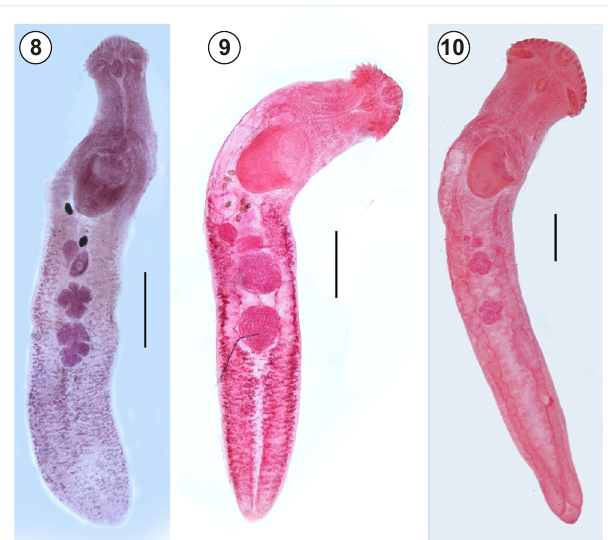
Austrodiplostomum ostrowskiae Dronen, 2009.